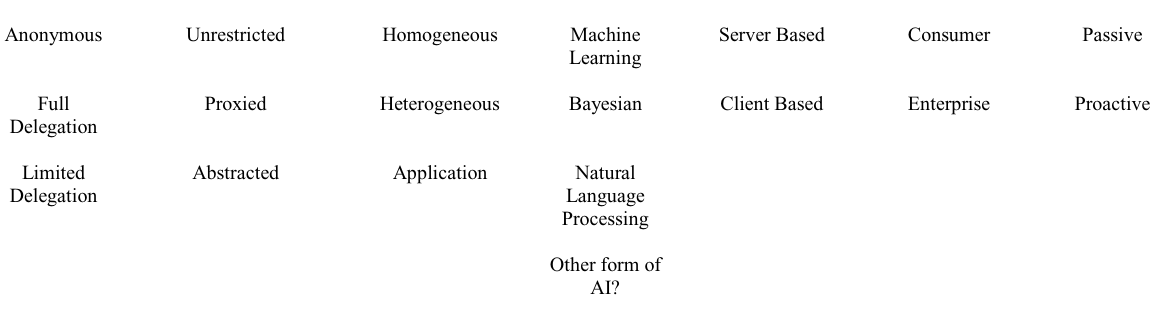
Table 5. Mashup Classification